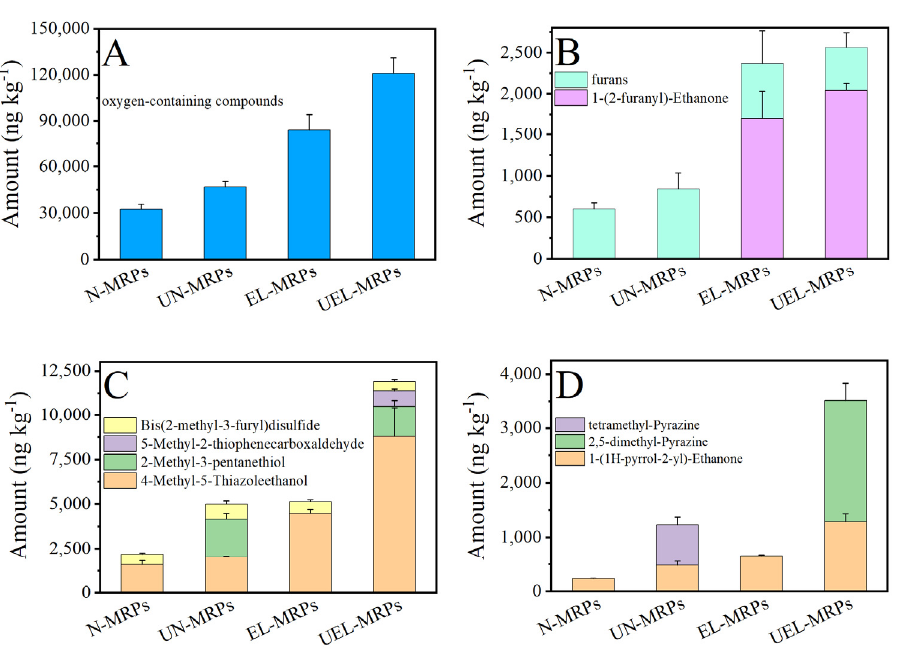
Figure 2. ( A ) The total amount of oxygen-containing compounds in various MRPs. ( B ) The amount of furans and 1-(2-furanyl)-ethanone in various MRPs. ( C ) The total amount of sulfur-containing compounds in various MRPs. ( D ) The total amount of nitrogen-containing compounds in various MRPs.